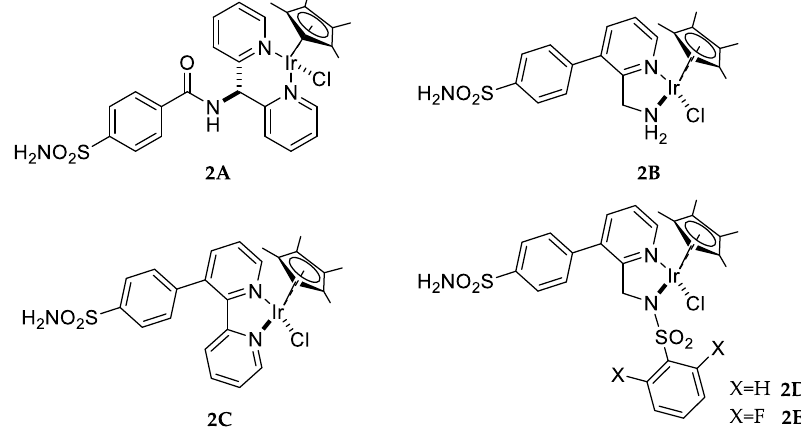
Figure 7. Pianostool complexes 2A–E